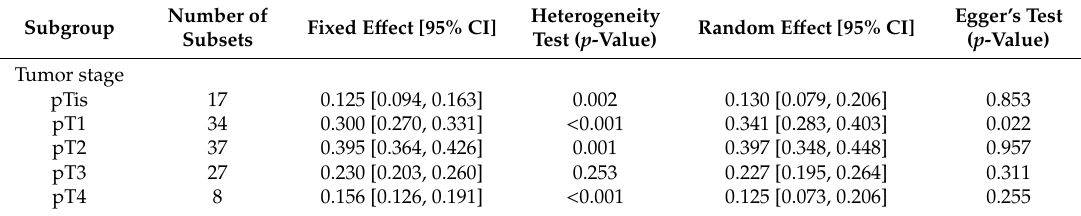
Table 4. The estimated rates of tumor stages of incidental gallbladder cancer after